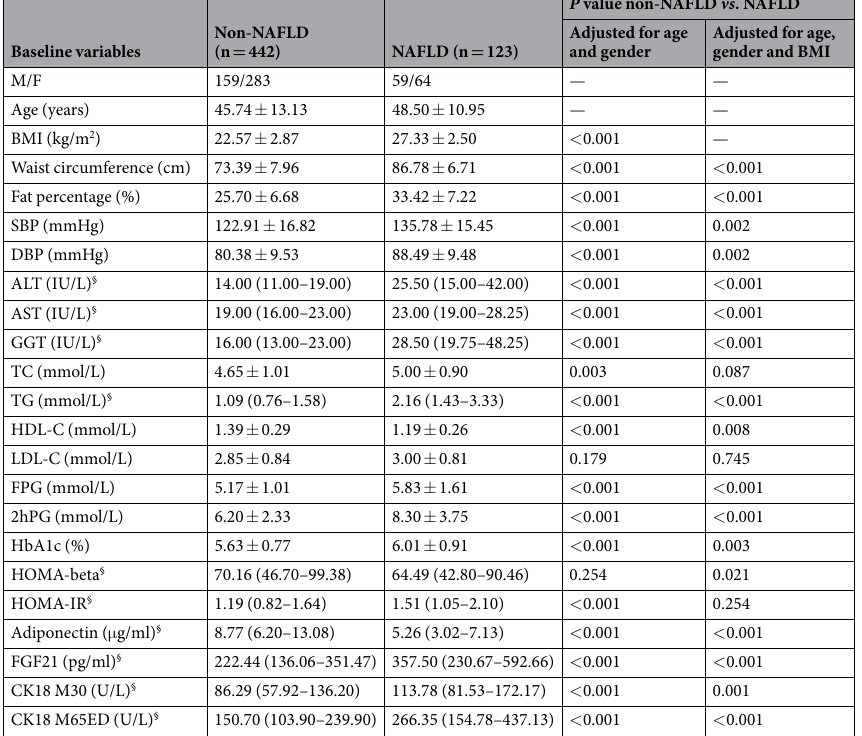
Table 1. Baseline characteristics of subjects with non-NAFLD and NAFLD. Data are means ± SD or median (interquartile range). § Ln transformed before